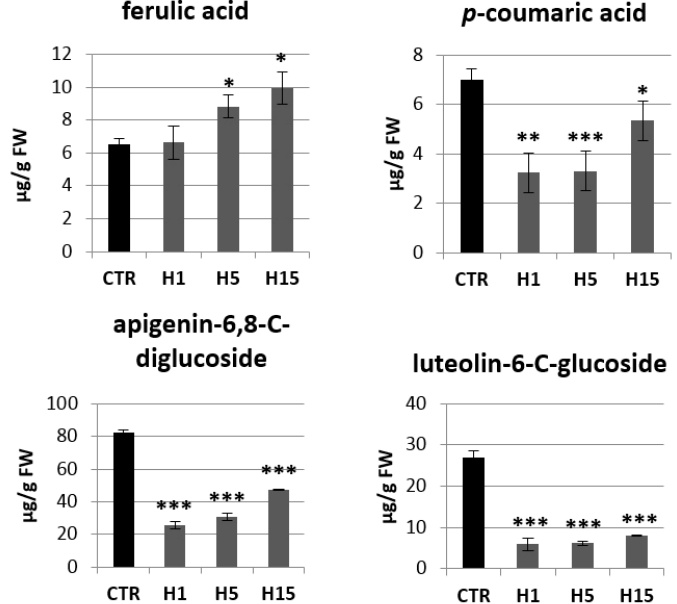
Figure 8. The levels of selected phenolics (ferulic acid, p -coumaric acid, apigenin-6,8-C-diglucoside, luteolin-6-C-glucoside) of the phenylpropanoid pathway in transgenic flax plants. Content of selected phenolic compound in 5-week-old plants (stems and leaves) from in vitro culture of transgenic flax lines H1, H5, H15, and control flax (CTR). The content of metabolites was obtained from the UPLC analysis. Calculations were performed using MassLynx software. The results are presented as mean values of three independent repeats ± SD. Statistically significant differences between the means were marked with asterisks (* - p < 0.05, ** - p < 0.01, *** - p < 0.001).